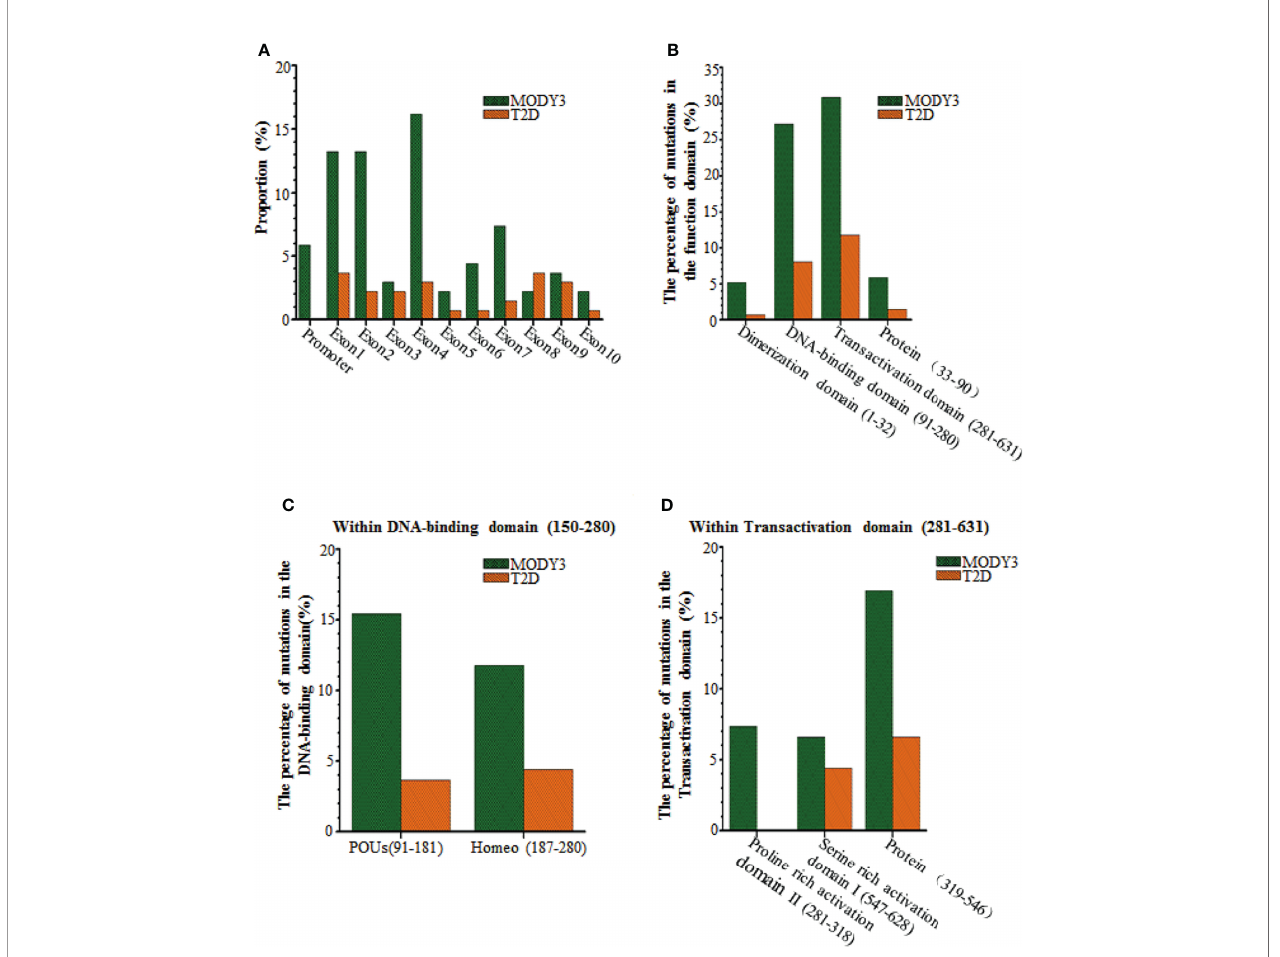
FIGURE 2 | Comparisons of the HNF1a SNPs causing MODY3 with the HNF1a SNPs causing T2D. (A) Location within the promoter and 10 exons, (B) Location within the functional domains of HNF1 a protein, (C) Location within DNA-binding domain of HNF1 a protein, (D) Location within transactivation domain of HNF1 a